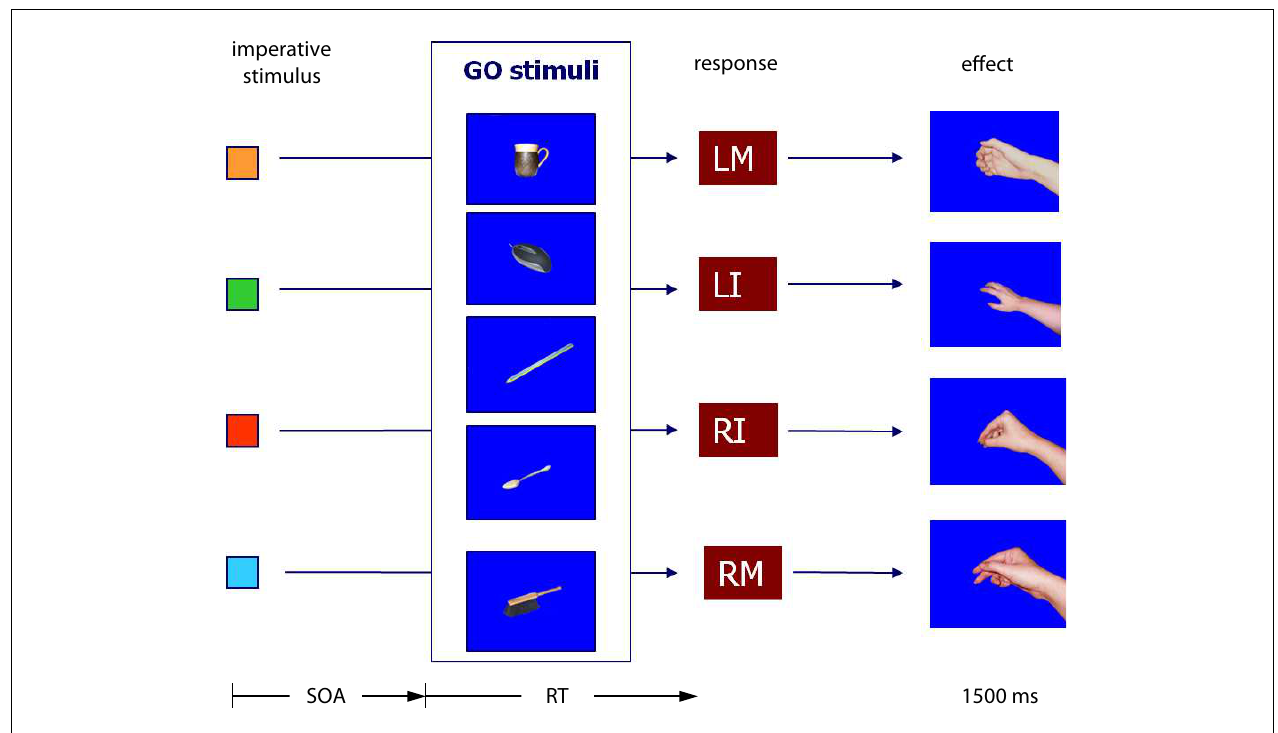
brush is unrelated to all effect stimuli and was therefore incompatible to all of them. LM, left middle finger; LI, left index finger; RI, right index finger; RM, right middle finger.The SOA was 0, 150, 300, or